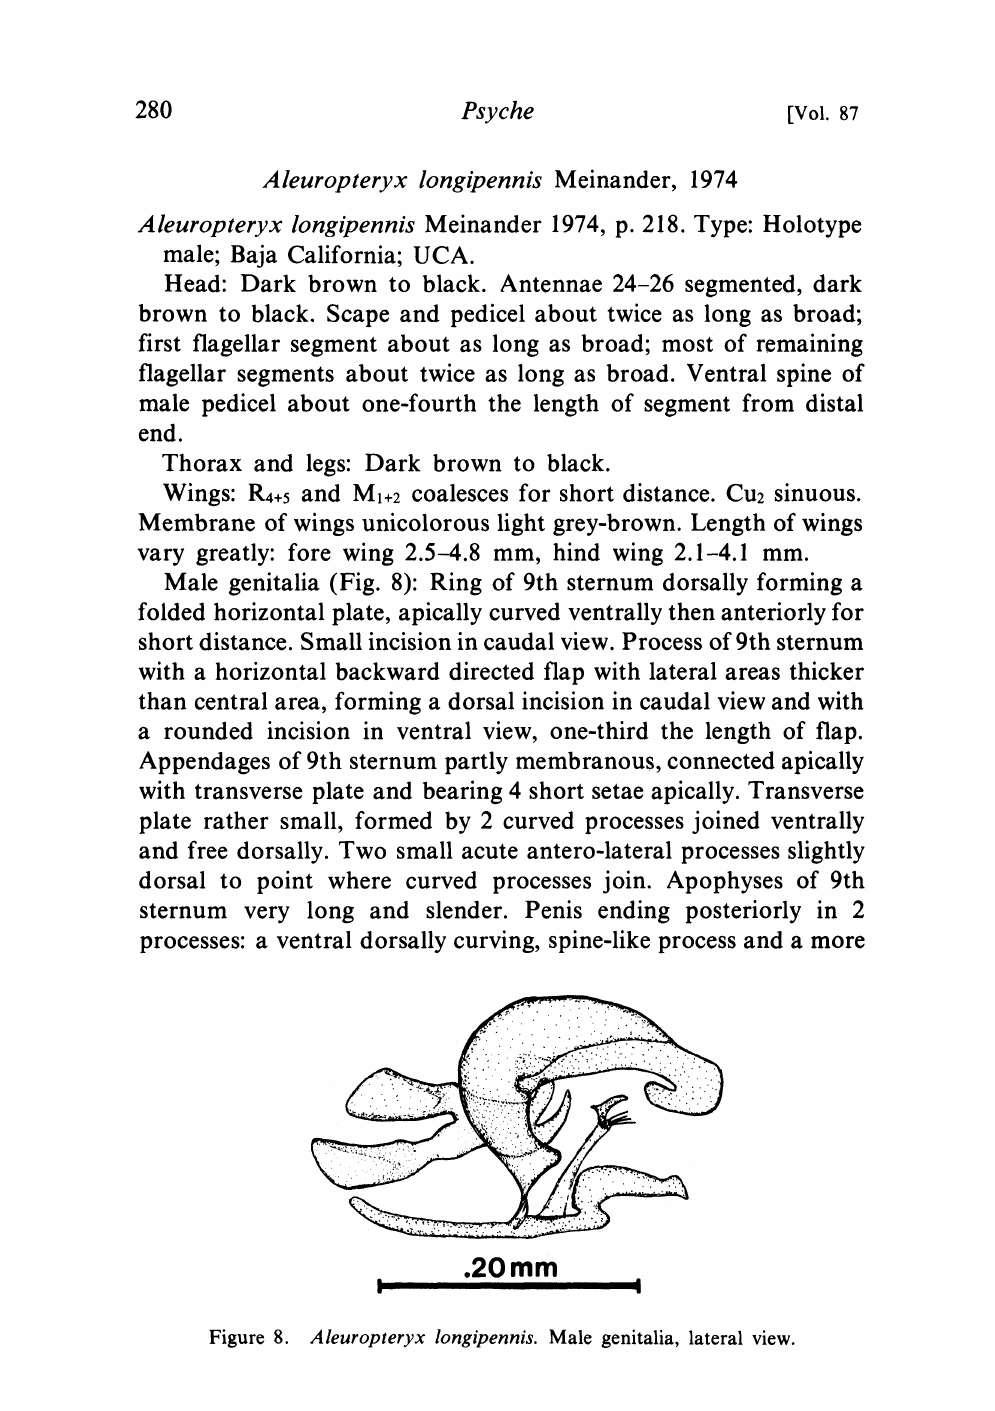
Figure 8. Aleuropteryx longipennis. Male genitalia, lateral